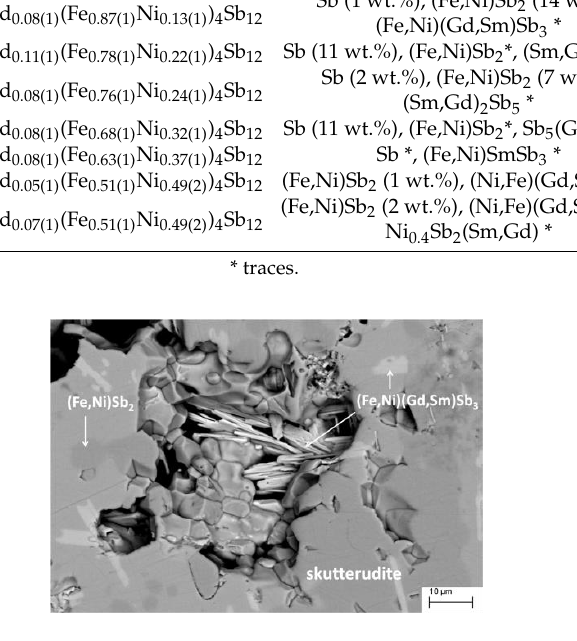
Figure 1. SEM microphotograph taken by backscattered electrons on the polished surface of sample Fe90_bulk.